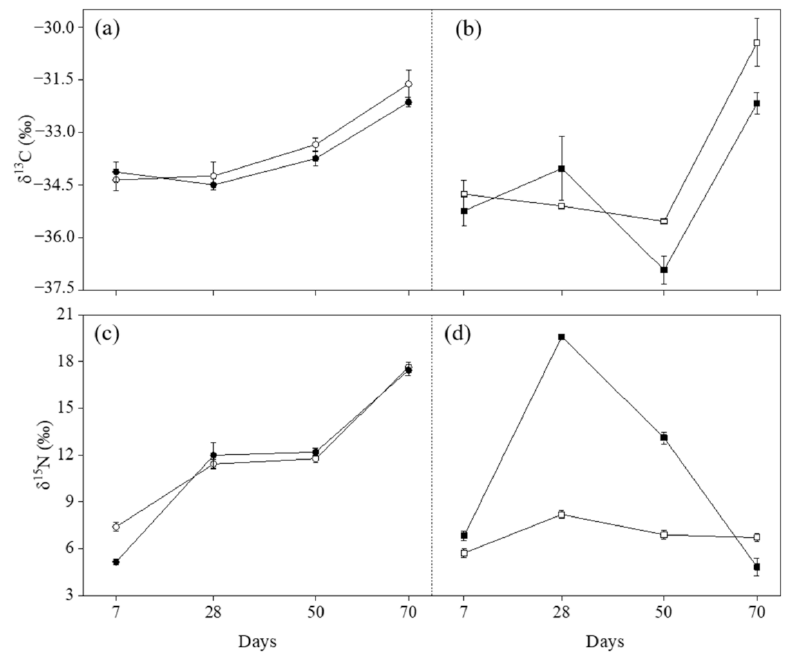
Figure 4. δ 13 C ( a , b ) and δ 15 N ( c , d ) values in durum wheat cultivars Claudio (circle, left ) and Mongi- bello (square, right ) exposed to 0 (open) or 80 (closed) ppb of ozone (5 h day − 1 ) at different growth stages (7, 28, 50, 70 days from the beginning of exposure). Data are shown as mean ± standard deviation (n = 3). A vertical dashed line separates the